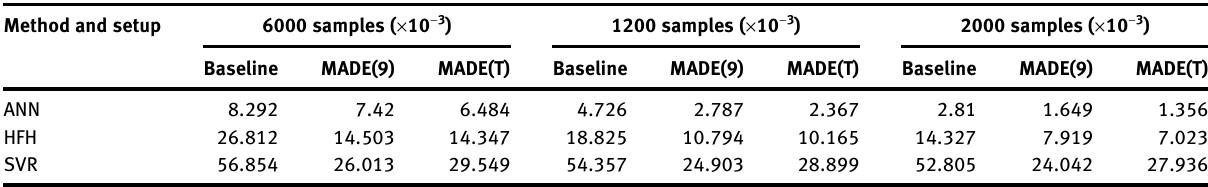
Table  : Mean absolute error (MAE) of arti fi cial neural network (ANN), random forest regression (RFR), and support vector regression (SVR) regarding the second category metamaterials. Method and